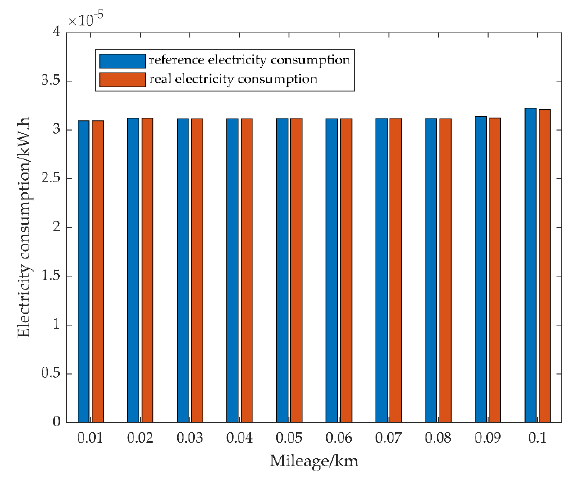
Figure 5. Battery power consumption while the vehicle is running.